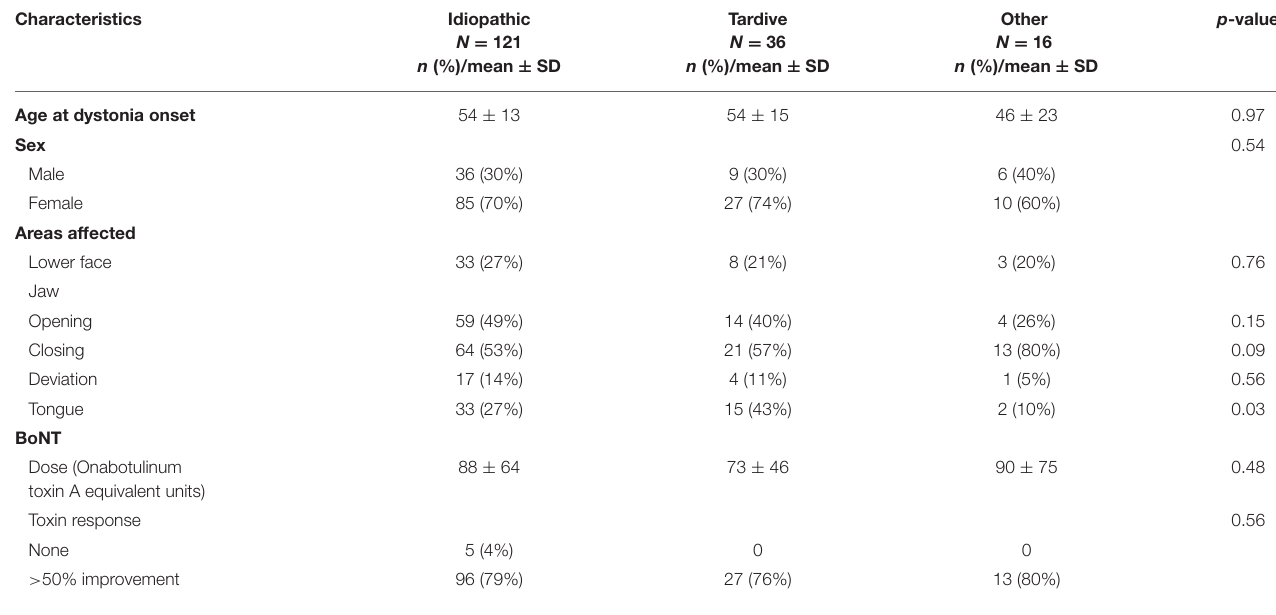
TABLE 5 | Variation in clinical characteristics and treatment response of oromandibular dystonia by etiology in expert center cases.